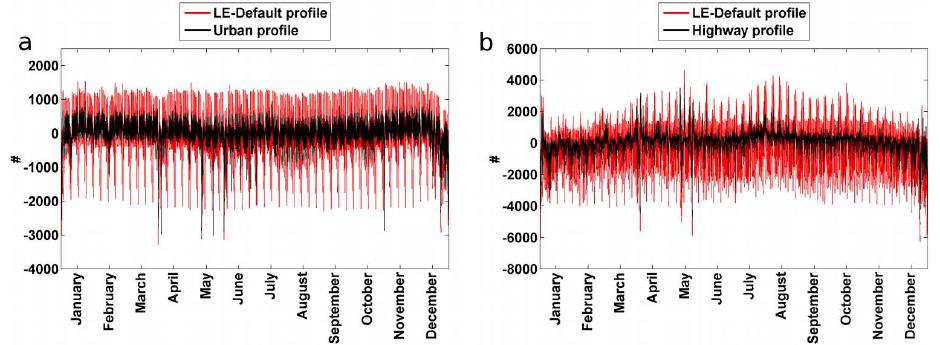
Fig. 2. Time series of the differences between actual traffic counts and the application of the default and the new urban and highway time profiles at an urban street station (Bottrop) (a) and a highway station (Lauenau) (b) in Germany for the year 2010.